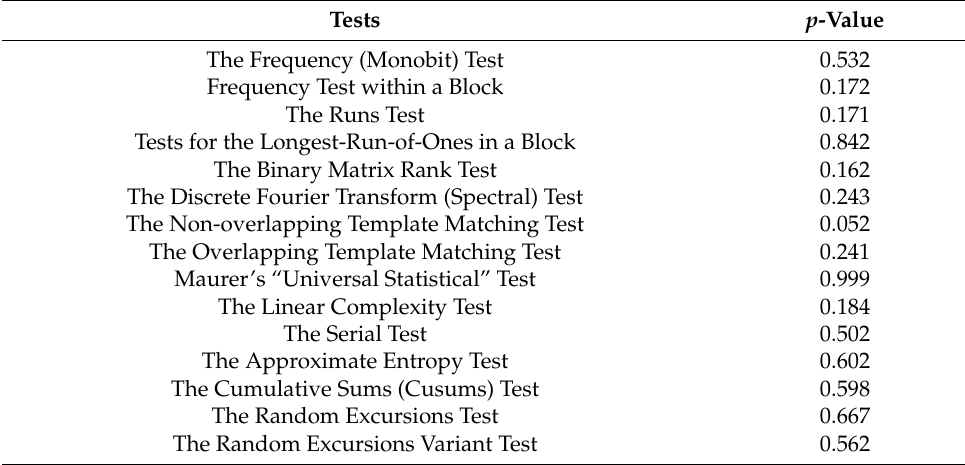
Table 3. Fifteen NIST randomness test